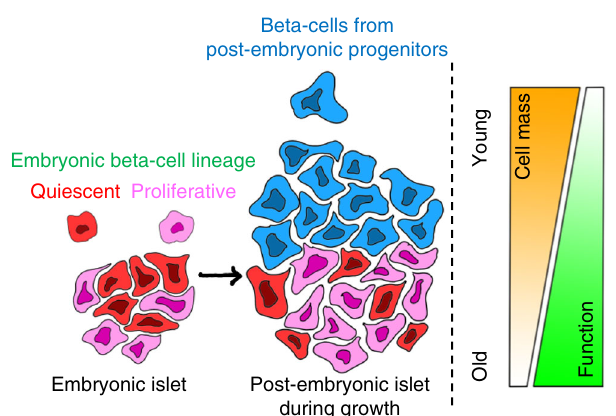
Fig. 7 Different developmental histories of beta-cells lead to functional and proliferative heterogeneity. A model showing that beta-cells within the same islet can exhibit different behaviors based on differences in the time of their differentiation, which can shape the islet ’ s functional heterogeneity during maturation. The increase in the islet ’ s beta-cell mass involves contributions from both the proliferation of embryonic beta-cells and the addition of post-embryonic beta-cells via progenitor differentiation. New beta-cells are added preferentially to the islet ’ s anterior regions ( top ), whereas the embryonic beta-cells localize to the posterior ( bottom ). Thus, the islet becomes polarized in regard to cellular age. The younger beta-cells have reduced glucose responsiveness but show higher proliferation compared to the older cells. Notably, this heterogeneity dampens with increasing age, likely as the result of reduced neogenesis and maturation of the islet ’ s younger the younger (GFP-negative) beta-cells were PCNA-positive, as compared to the older (GFP-positive) beta-cells (Fig. 6b, c). Thus, de novo beta-cell formation provides a pool of cells with a higher proliferative potential.